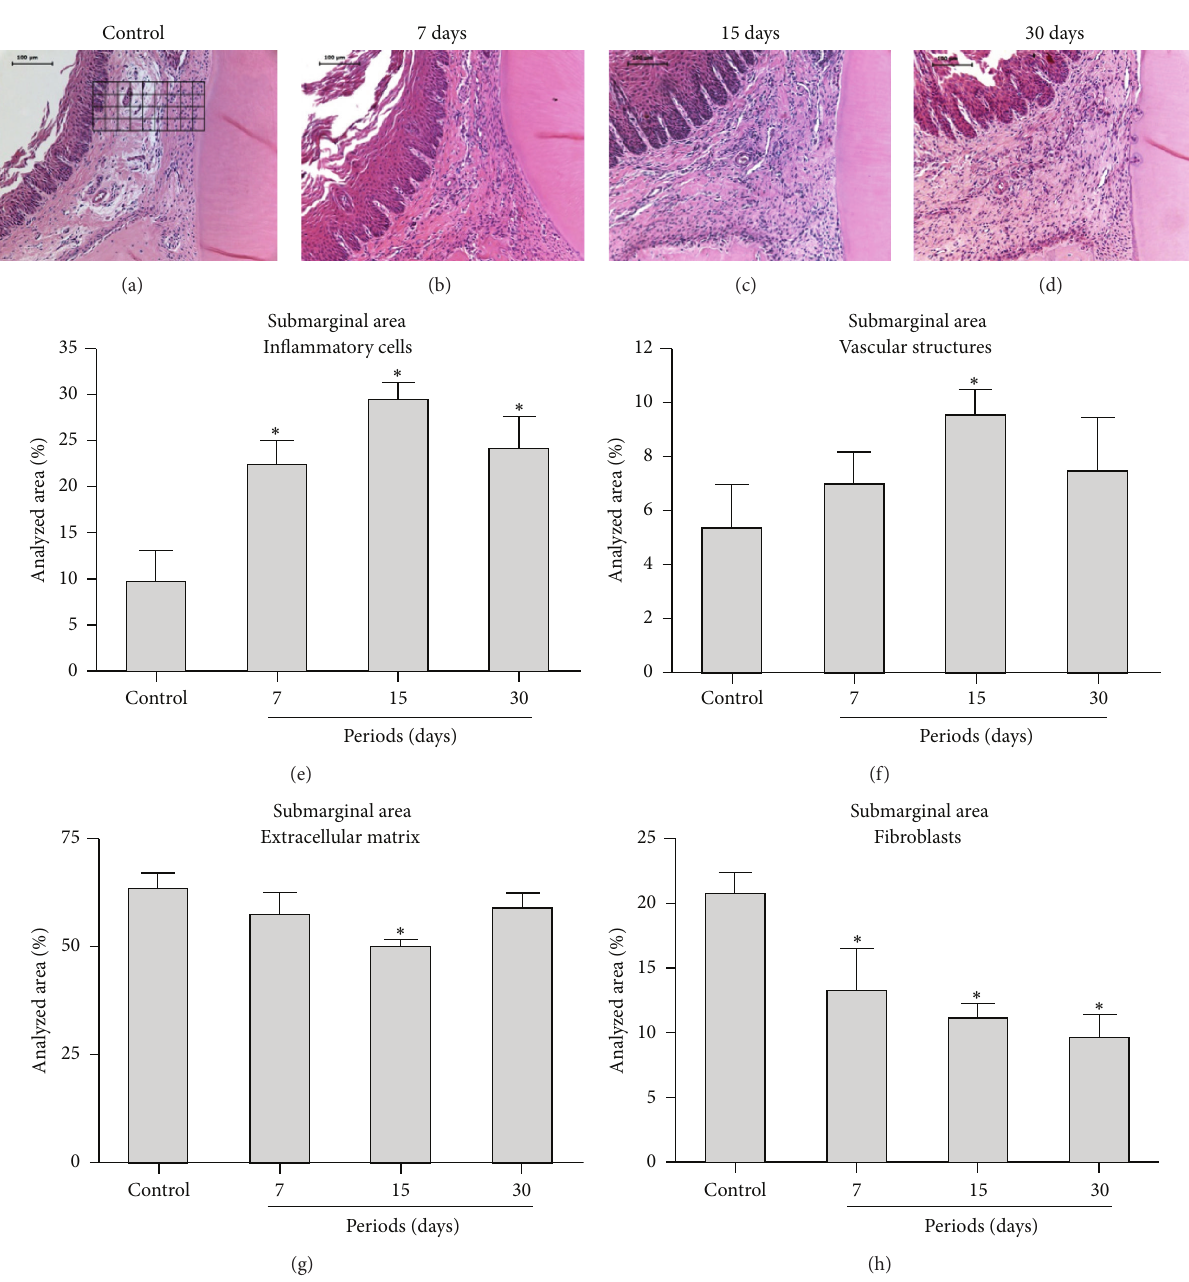
Figure 1: Representative images and stereometric analysis of each experimental period (7, 15, and 30 days) for the LPS-injected tissues (experimental group). A single representative image of the control group is shown, as no important changes were noted in this group in the different experimental periods (data not shown). The general characteristics of the inflammatory reaction include increase in inflammatory- like cell density and vascular structures, and a decrease in the number of fibroblast-like cells and extracellular matrix content was observed in all experimental periods. The image of a control site depicts the placement of the 3240 𝜇 m 2 grids on the submarginal area limited coronally by the apical border of the junctional epithelium and laterally by the tooth structure. Stereometric analysis indicates that LPS injections caused a sustained inflammatory reaction. The relative presence of inflammatory cells, vascular structures, fibroblasts, and extracellular matrix in 32400 𝜇 m 2 area (schematically shown on (a)) was analyzed. The severity of inflammation was significantly higher in comparison to the control group throughout the 30-day experimental period. ∗ Significant differences compared with control groups ( 𝑃 < 0.05 , ANOVA, and post hoc Tukey for pairwise